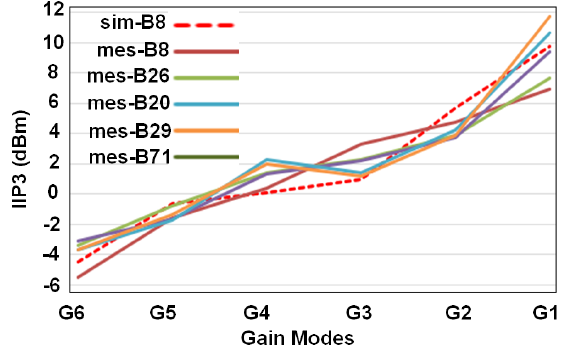
Figure 7. Simulated and measured IIP3 for different bands.